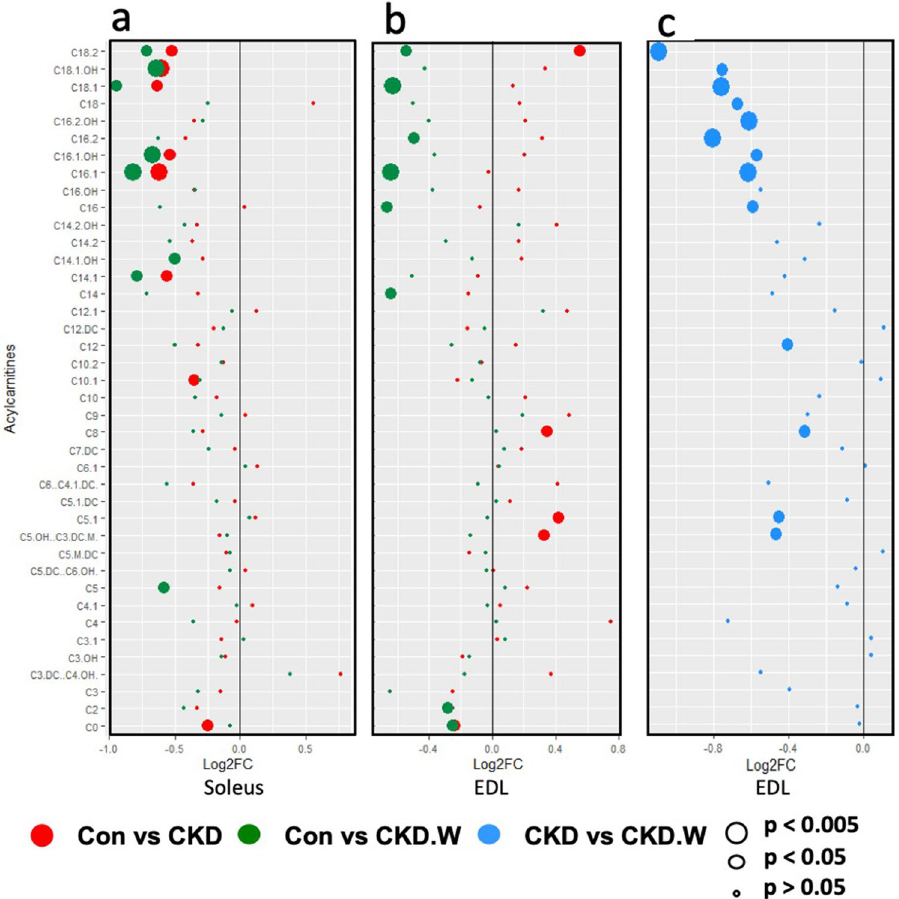
Figure 3. Forest plot of the tissue acylcarnitine levels in the soleus and EDL. The log2 fold changes for the acylcarnitines are plotted for the ( a ) soleus and ( b , c ) EDL. The red dots compare the fold change between the NL and CKD rats, green dots between the NL and CKD-W and the blue dots between the CKD and CKD-W. The dot size correlates with the p value with the largest dots having p values < 0.005, medium dots < 0.05 and small dots > 0.05. The fold comparisons demonstrate group differences where left of center CKD is lower than NL (red dot), CKD-W is lower than NL (green dot), and CKD-W is lower than CKD (blue